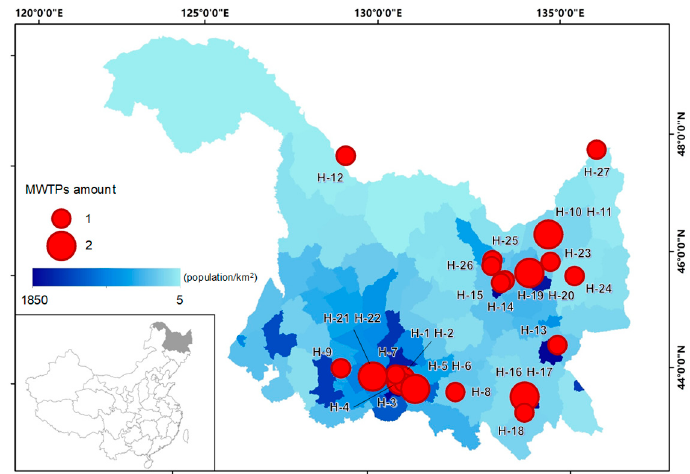
Figure 1. Locations of the municipal wastewater treatment plants (MWTPs) for this study. The date on the distribution of the population is from the census information in 2018 [25].